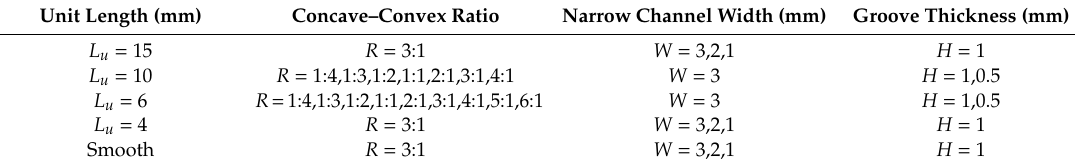
Figure 8. Variation in the friction factor of the narrow channel under different R and H (Re = 3750). ( a ) u L = 6 mm; ( b ) u L = 10 mm.